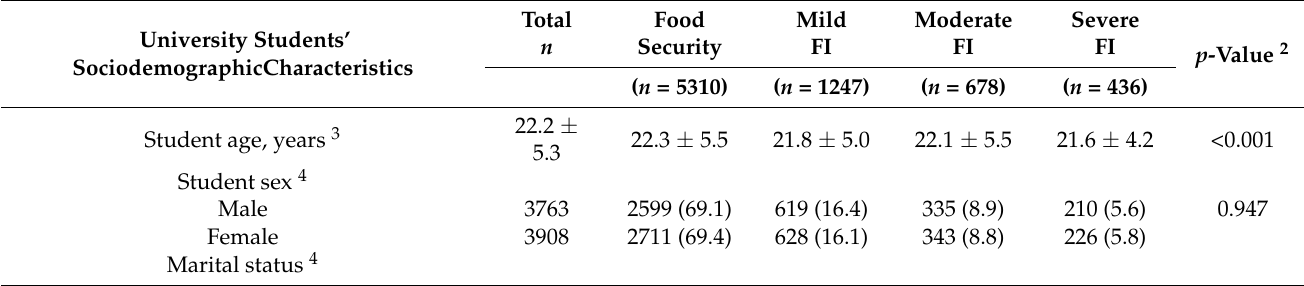
Table 1. Sociodemographic characteristics of Mexican university students’ households according to food insecurity (FI) categories 1